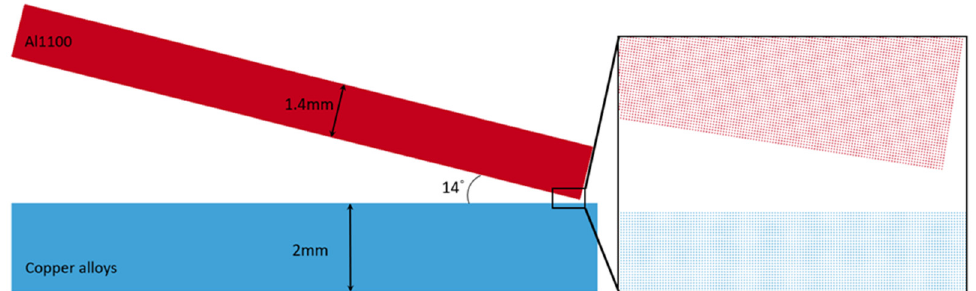
Figure 10. SPH model defined in LS-PREPOST.